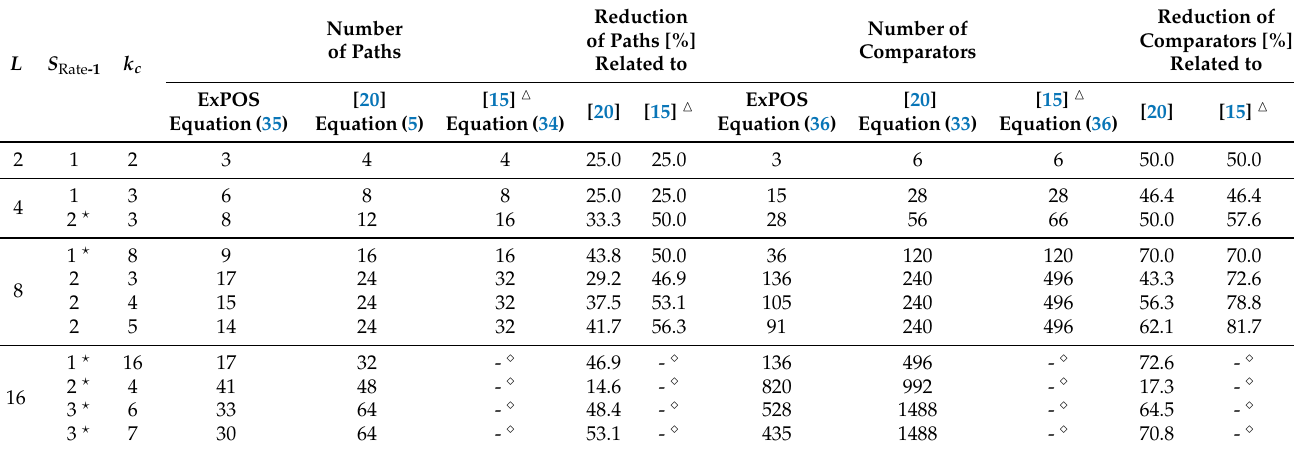
Table 1. Comparison of number of paths and